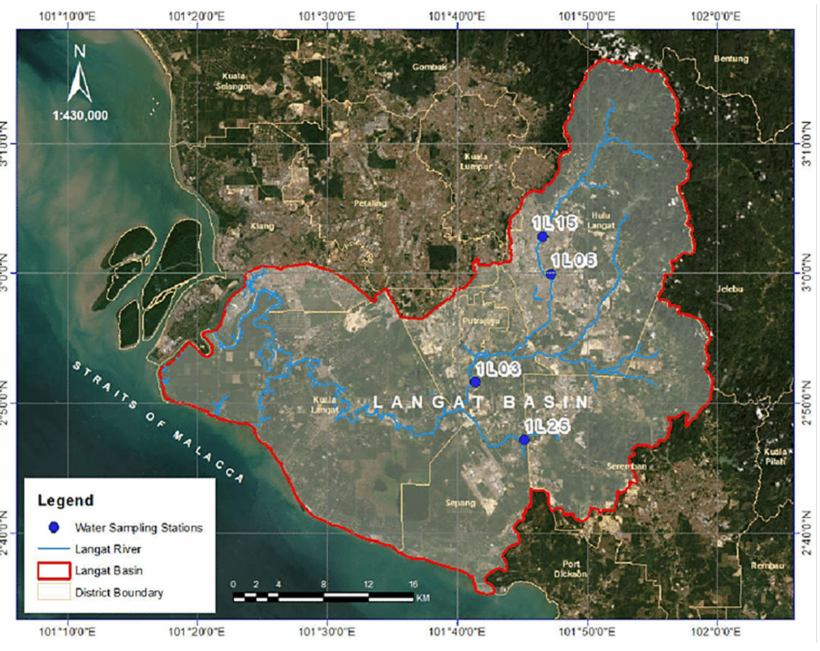
Figure 1. Langat River Basin [23].